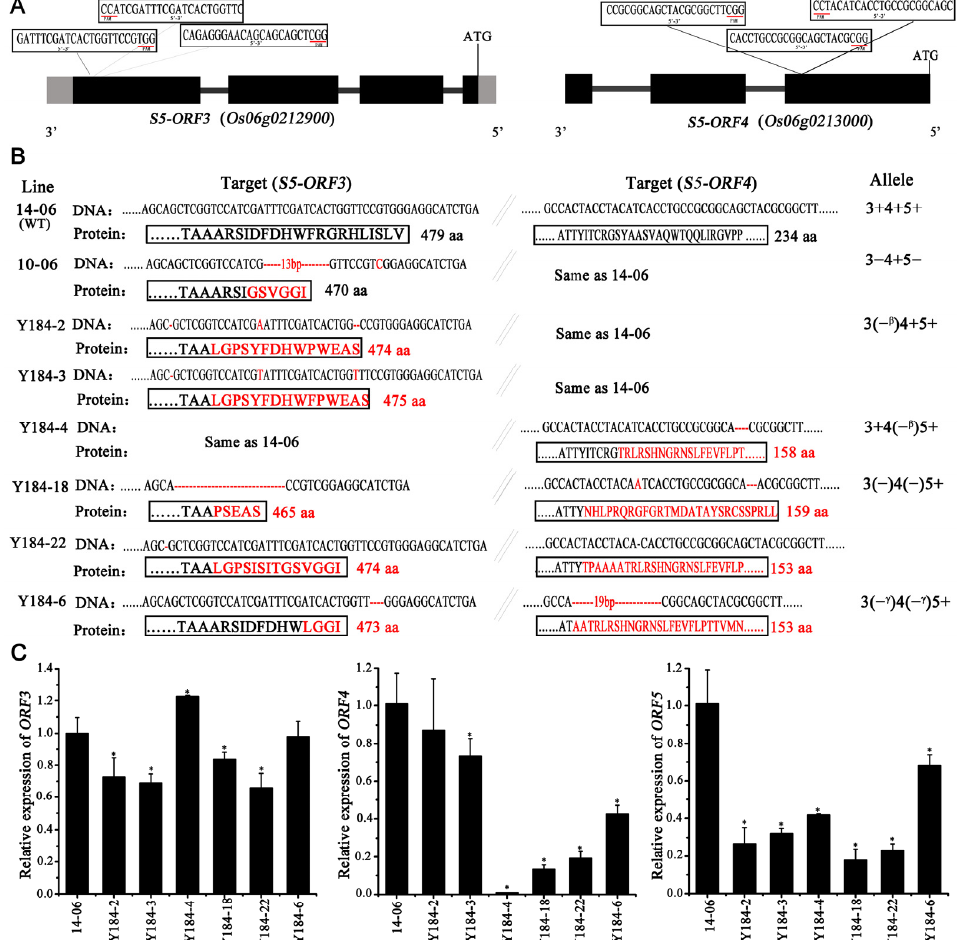
Figure 4. CRISPR/Cas9-mediated editing of ORF3 and ORF4 gene in HJX74-SSSL ( A ) Target sites in ORF3 or ORF4 for the CRISPR/Cas9 editing. The black boxes represent the exons. Two target sites are located on the four exons of the ORF3 or the first exon of ORF4 . The target sites were located in frames. ( B ) Sequencing of the CRISPR/Cas9-targeted sites in ORF3 (left) and ORF4 (right). The PCR fragments containing the targeted sites were directly sequenced. The wild-type sequences in 14-06 were as references. The positions highlighted in red show the targeted mutations and deletions indicated by the red dash “ − ”. ( C ) qRT-PCR analysis of ORF3 , ORF4 , and ORF5 in young panicles of different gene-edited lines. Profilin was the reference gene. Results were presented relative to the expression level of three ORF s in 14-06. * Significantly different at 0.05 probability level.